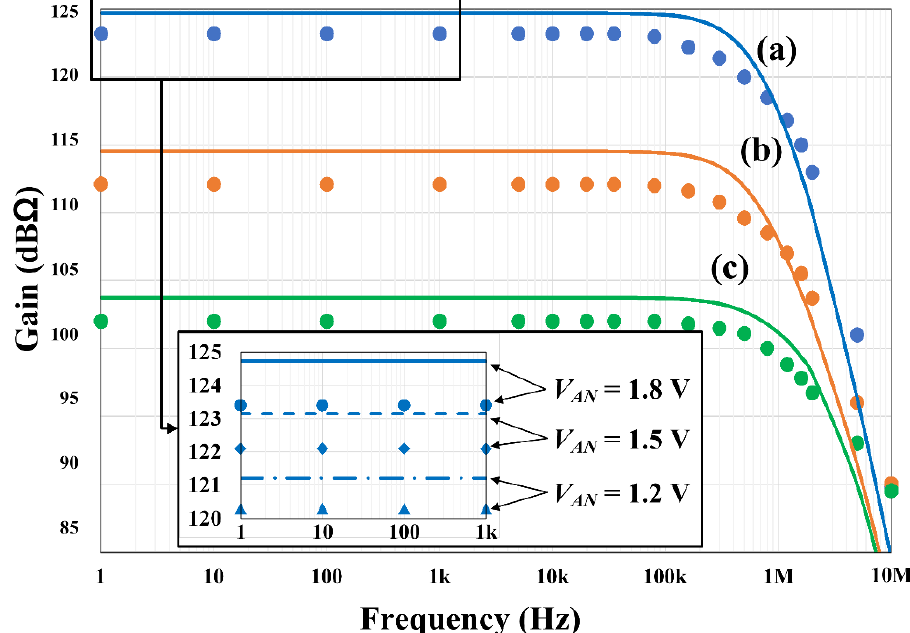
Figure 6. AC sweep analysis performed with the CMOS integrated TIA for different values of the digital control voltages V 1 , V 2 , and V 3 by fixing the analog voltage V AN = 1.8 V: plot (a) V 1 = V 2 = 0 and V 3 =1.8 V; plot (b) V 1 = V 3 = 0 V and V 2 = 1.8 V; plot (c) V 2 = V 3 = 0 V and V 1 = 1.8 V. Continuous lines have been calculated by using Equation (1); dots are the experimental data. The inset report for the variation in the transimpedance gain for three different values of the voltage V AN : continuous, dashed and dot-dashed lines are the theoretical values while dots, diamonds, and triangles are the experimental results.